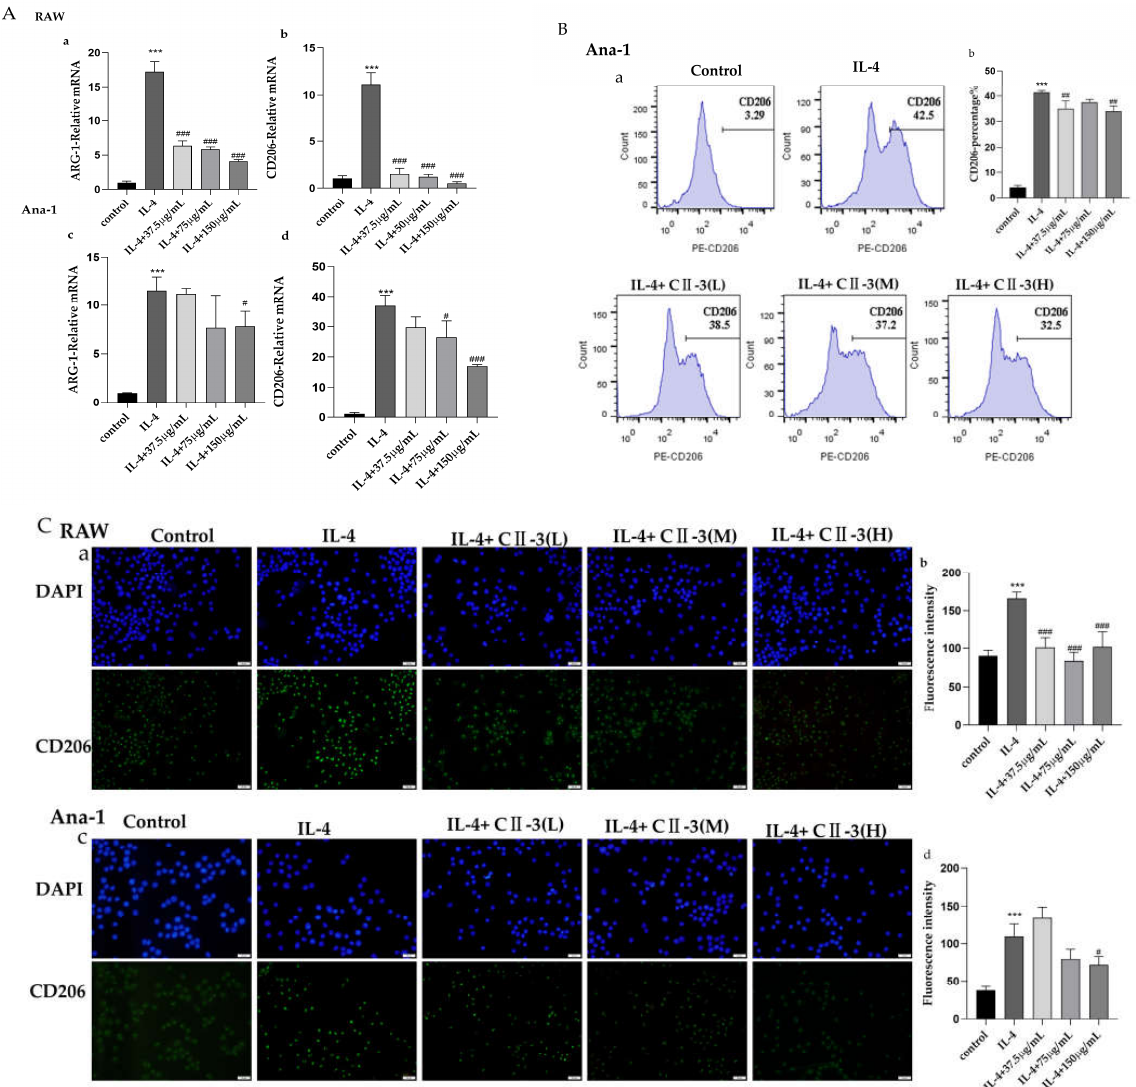
Figure 4. Impact of CII-3 on the expression of ARG-1 and CD206 in IL-4-induced RAW 264.7 and Ana-1 cells. ( A ): RT-PCR result of ARG-1 ( a , c ) and CD206 ( b , d ) in RAW 264.7 and Ana-1 cells; ( B ): Flow cytometry result of CD206 expression in Ana-1 cells ( a , b ); ( C ): Immunofluorescence result of CD206 expression in RAW 264.7 ( a , b ) and Ana-1 ( c , d ) (scale bar = 20 µm). *** p < 0.001 vs. the control group; # p < 0.05, ## p < 0.01, and ### p < 0.001 vs. the IL-4 group.